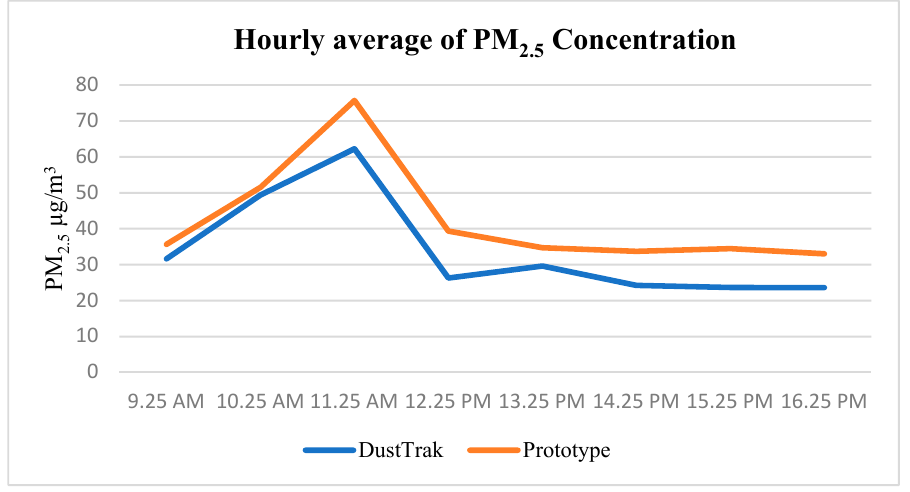
Figure 15. Hourly average of PM 2.5 mass concentration.